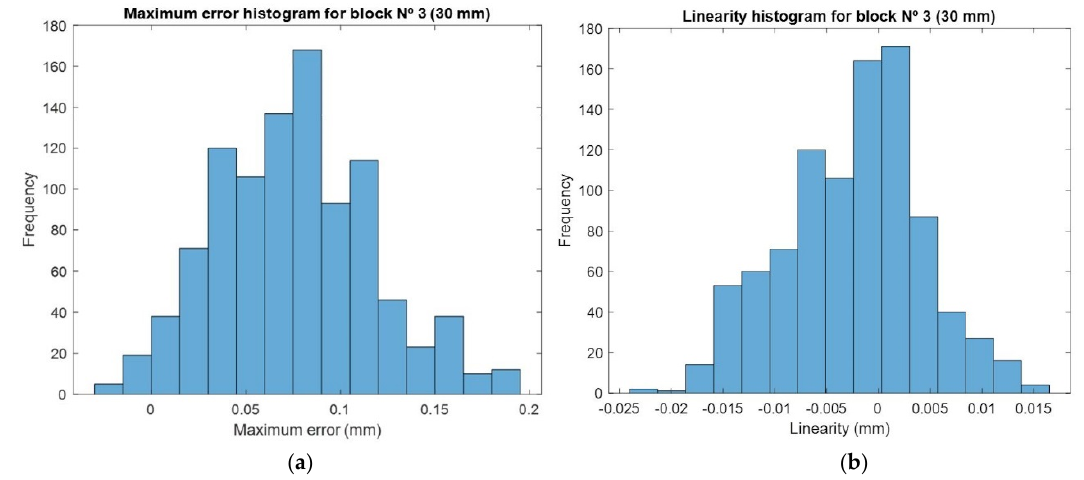
Figure 12. Histogram of all combinations for 30 mm height measurement: ( a ) histogram for maximum error values; ( b ) histogram for linearity values.